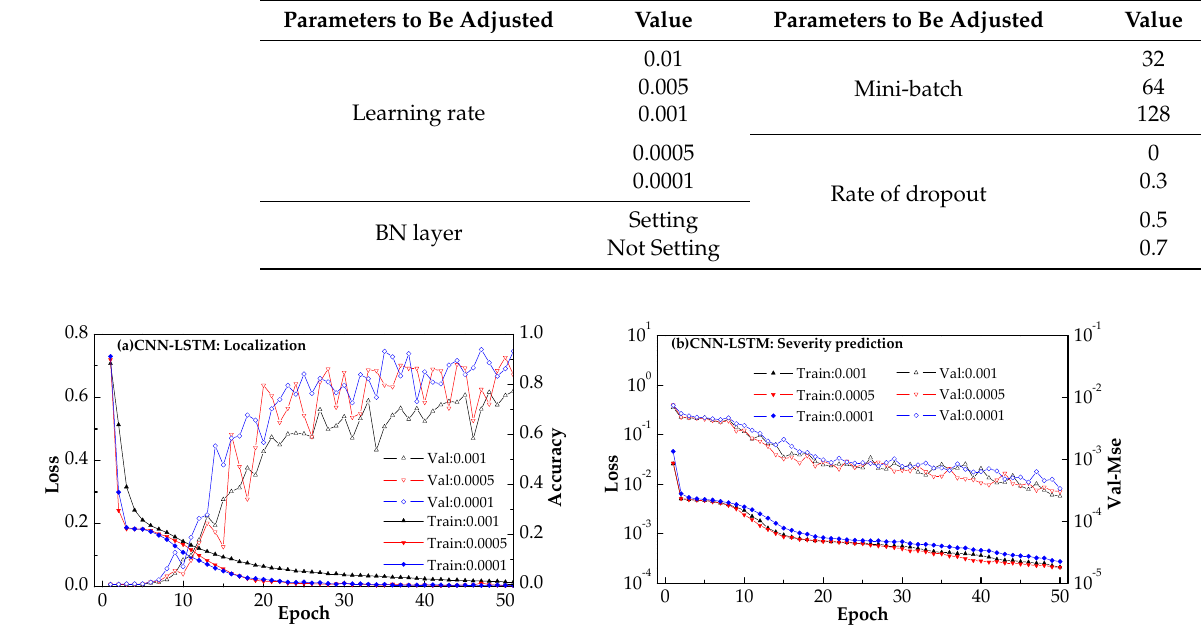
Table 3. Hyperparameters optimization of CNN-LSTM model. Figure 8 indicates that under different learning rates, the loss of CNN-LSTM used for